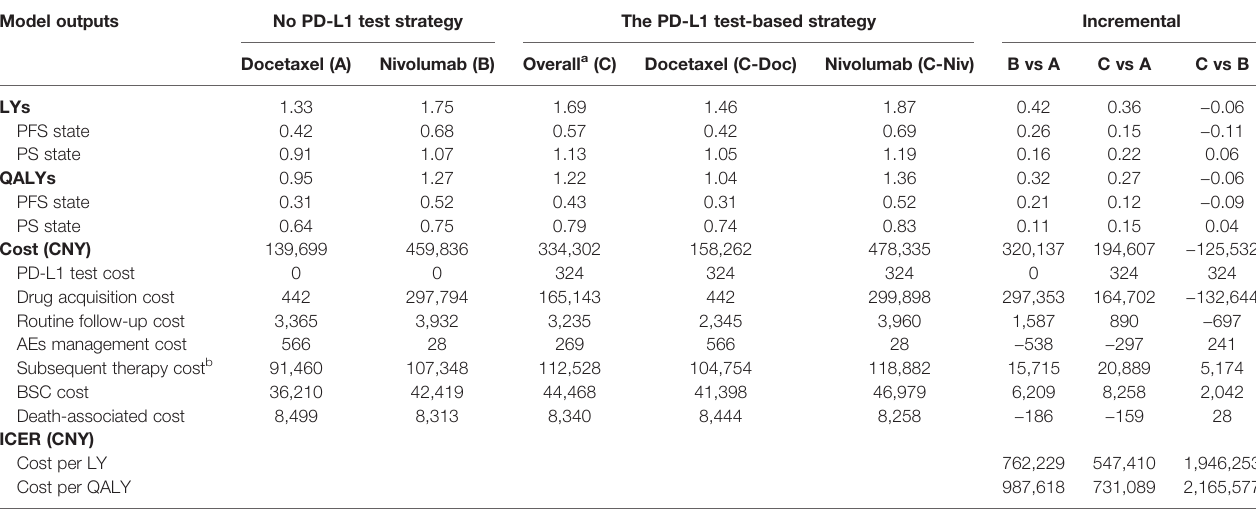
TABLE 2 | Summary base case